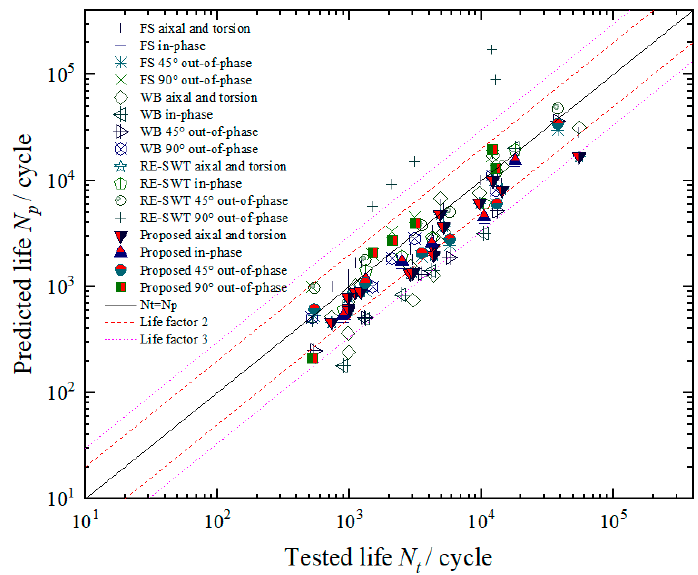
Figure 6. Fatigue life comparison of GH4169 under symmetric loadings.